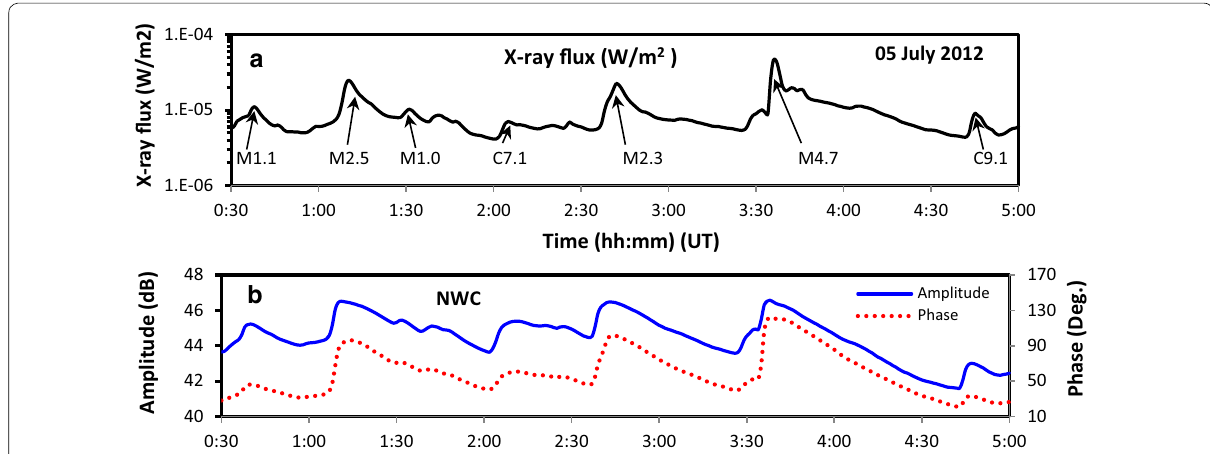
Fig. 2 a Variations in the GOES X-ray flux in W/m 2 during the solar flares of July 05, 2012. b Variations in the amplitude and phase of the NWC signal during the July 05, 2012, solar flares